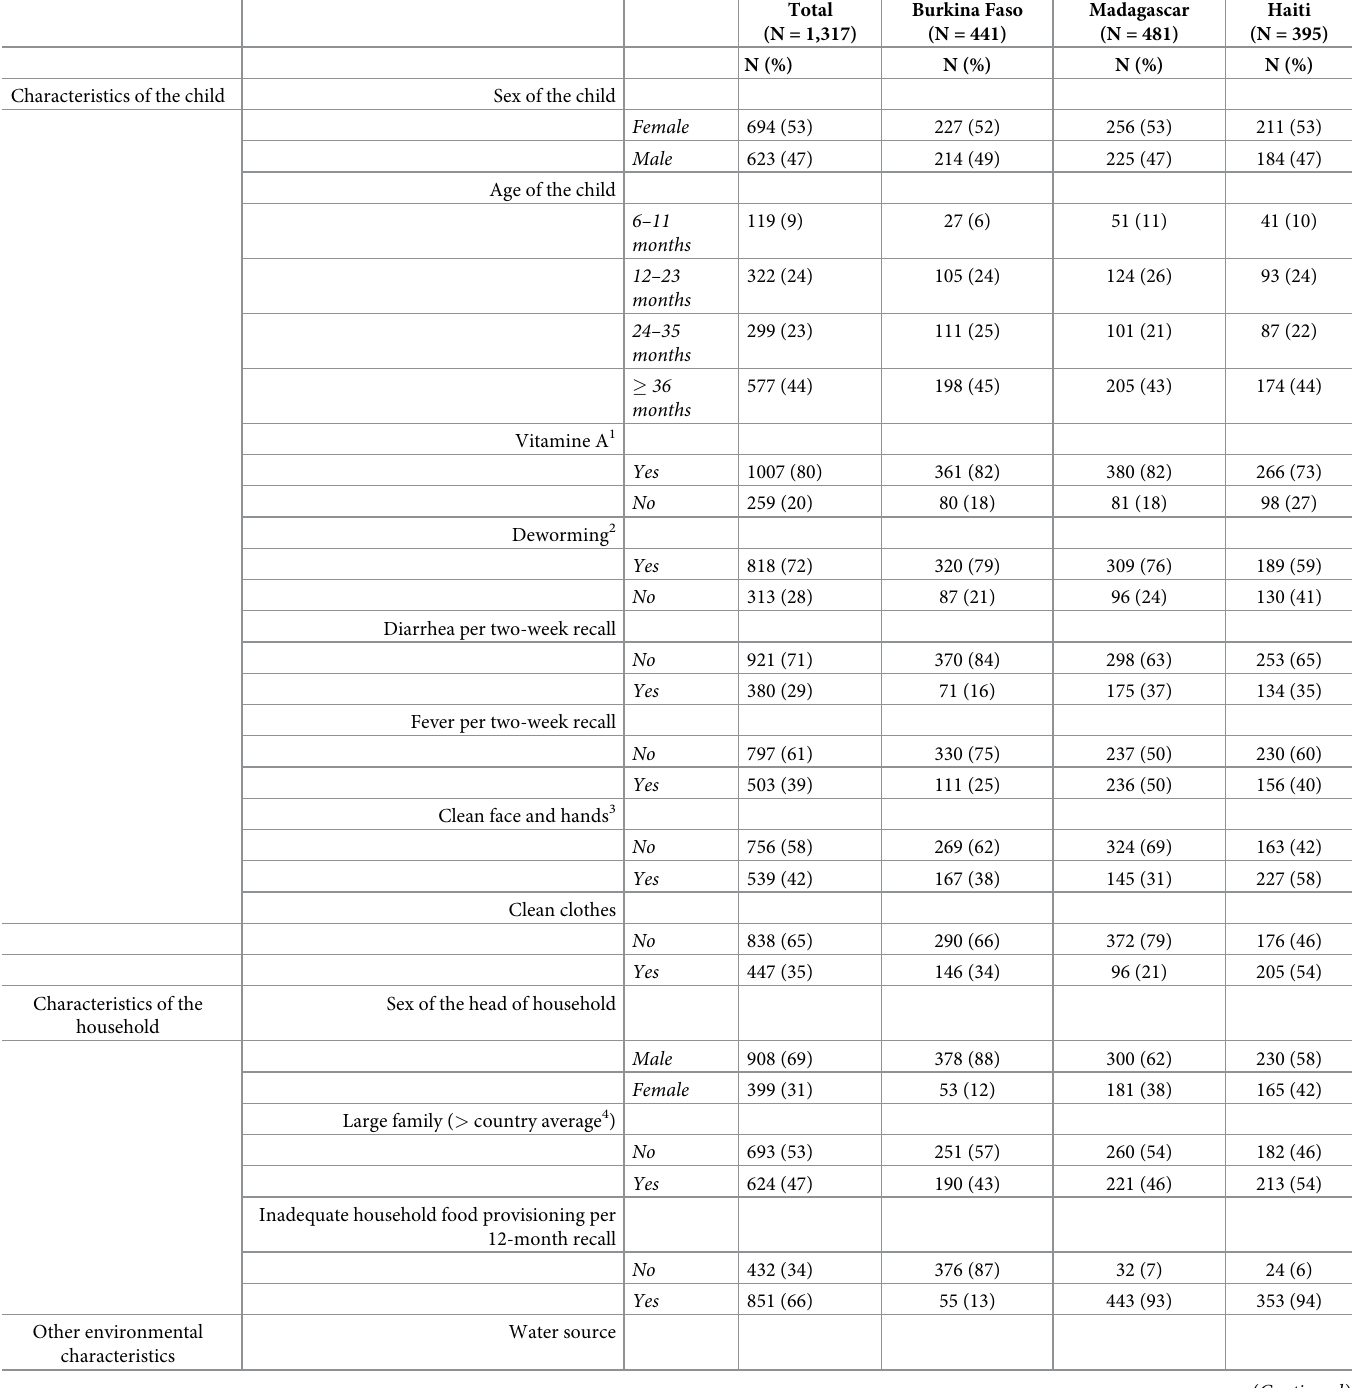
Table 2. Characteristics of the study population by country and